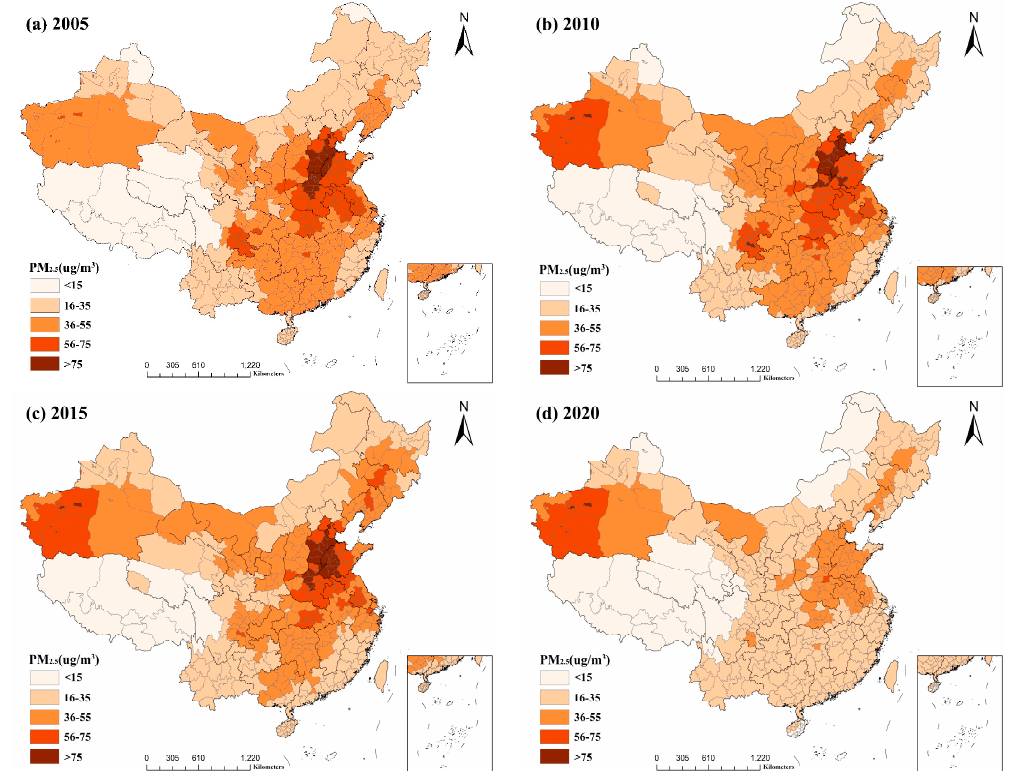
Figure 2. Spatial and temporal distribution of national PM2.5 concentrations from 2005 to 2020: ( a ) spatial and temporal distribution of PM2.5 concentrations in 2005; ( b ) spatial and temporal distri- bution of PM2.5 concentrations in 2010; ( c ) spatial and temporal distribution of PM2.5 concentrations in 2015; ( d ) spatial and temporal distribution of PM2.5 concentrations in 2020.